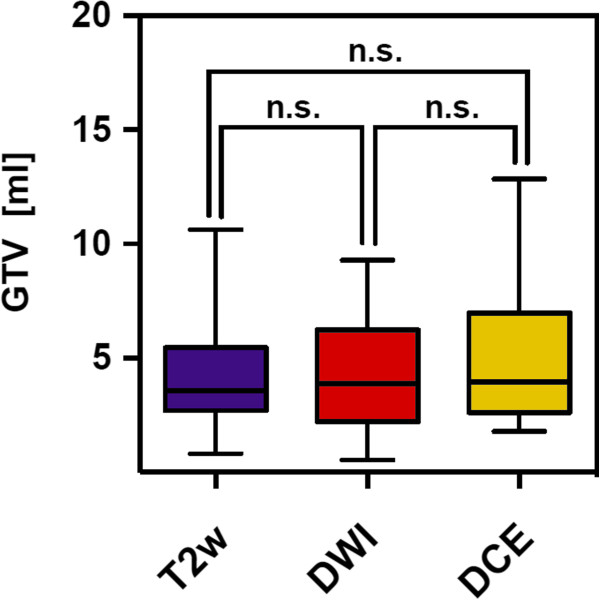
Box plots with median, standard deviation and range values of the GTV contoured by 6 observers (including reference observer) upon three different MRI-sequences for all patients. There were no statistical difference between the different GTV results for each sequence and for all patients together (n.s. = not significant).